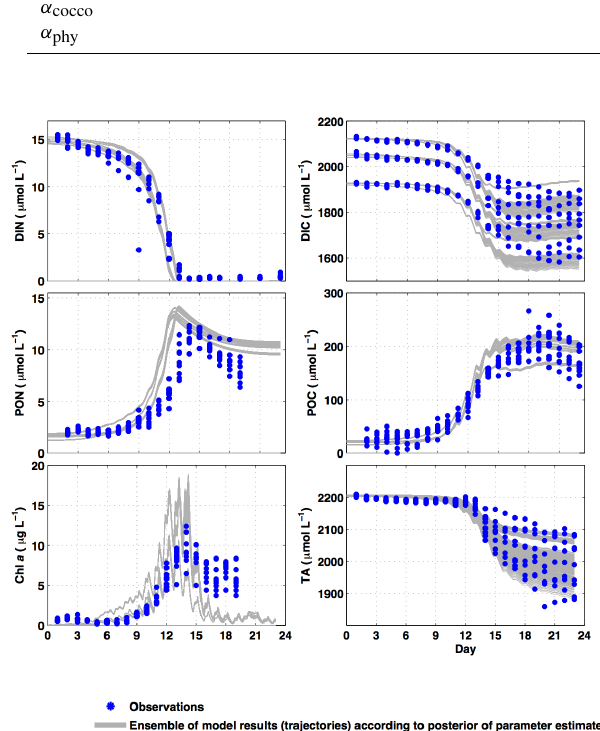
Figure 5. Full variational range of model outputs due to uncertain- ties in parameter estimates. Model ensembles of high, medium, and low calcification solutions compared with observations.